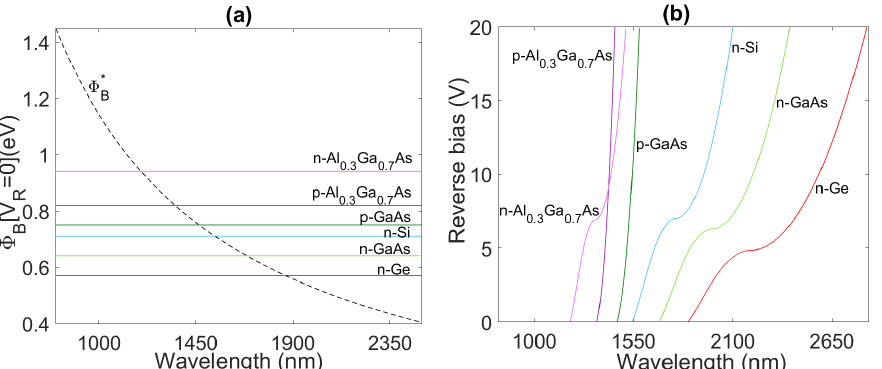
( λ ) at 300 K and the values of SBH Φ Figure 3. ( a ) Intersection between the curve Φ ∗ B0 at the B interface between graphene and several semiconductors in conditions of thermal contact (no voltage applied to the junction); ( b ) reverse voltage V R to apply to the graphene/semiconductor junction as function of the wavelength for maximizing the signal-to-noise ratio ( SNR ) ( Φ B = Φ ∗ ) for various B semiconductors. The values of Φ B0 = Φ B ( V R = 0 ) were calculated through Equations (15)–(18) by considering an initial graphene p-doping of n 0 = 10 12 cm − 2 and a doping of N = 10 16 cm − 3 for all the semiconductors reported in Table 2.